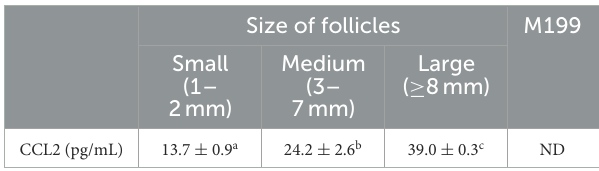
TABLE 1 Concentration of CCL2 in pFF from different follicle size (small, medium, and